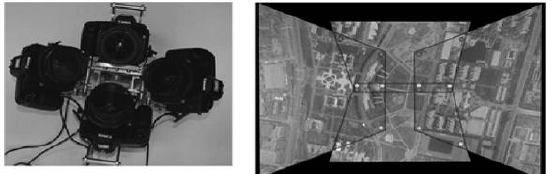
Figure 10. The design of the self-calibration function of four-